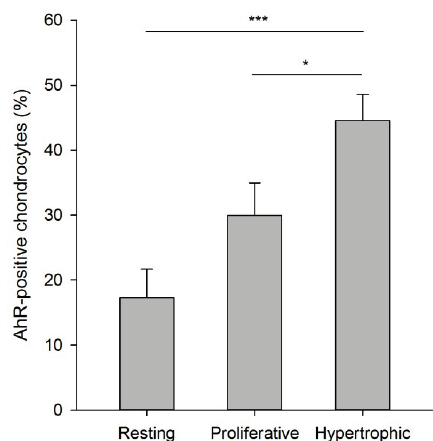
Figure 2. Percentage of AhR-positive chondrocytes in human growth plate tissue,